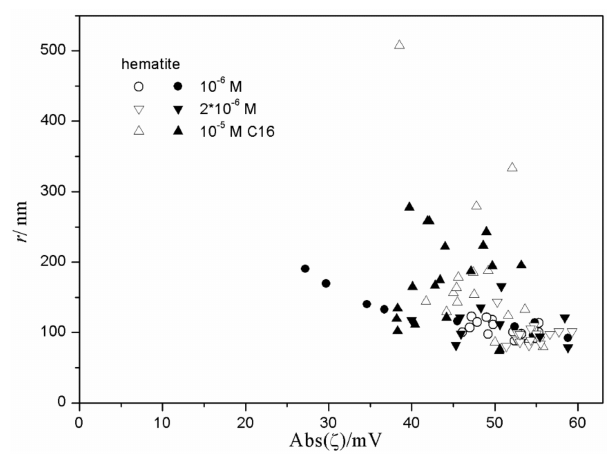
Figure 10. The particle size as a function of | ζ | in fresh (white points) and aged (black points) dispersions of hematite in the presence of sodium hexadecylsulfate.